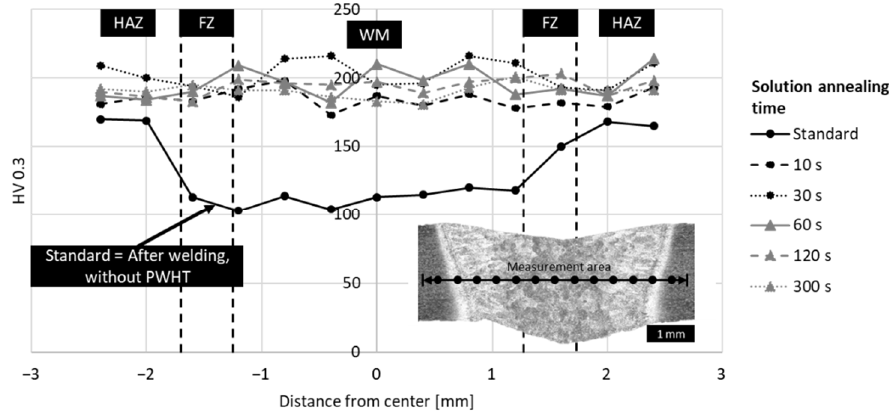
Figure 13. Hardness distribution of the welding seam. Variation of solution annealing time during PWHT.